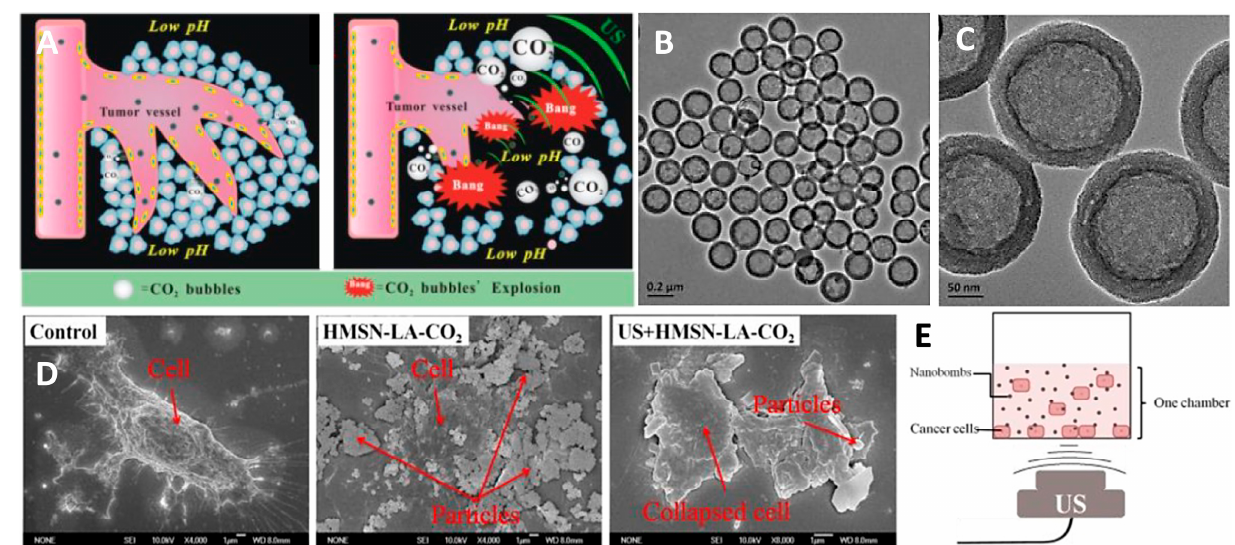
Figure 5. ( A ) Schematic diagram of CO 2 nanobubble physiotherapy mechanism. The nanobomb sys- tem can be driven by ultrasound to generate thermal energy through the cavitation effect. ( B , C ) Characterization of nanobombs based on carbon dioxide nanobubbles in TEM images. ( D ) Therapeutic outcomes were assessed in vitro by inducing apoptosis in PANC-1 pancreatic cancer cells using a constructed CO 2 bubbling-based system. ( E ) Schematic diagram of the measuring apparatus for in vitro PANC-1 cell experiments. Adapted with permission from Ref. [108]. Copyright 2015 Ivyspring International Publisher.